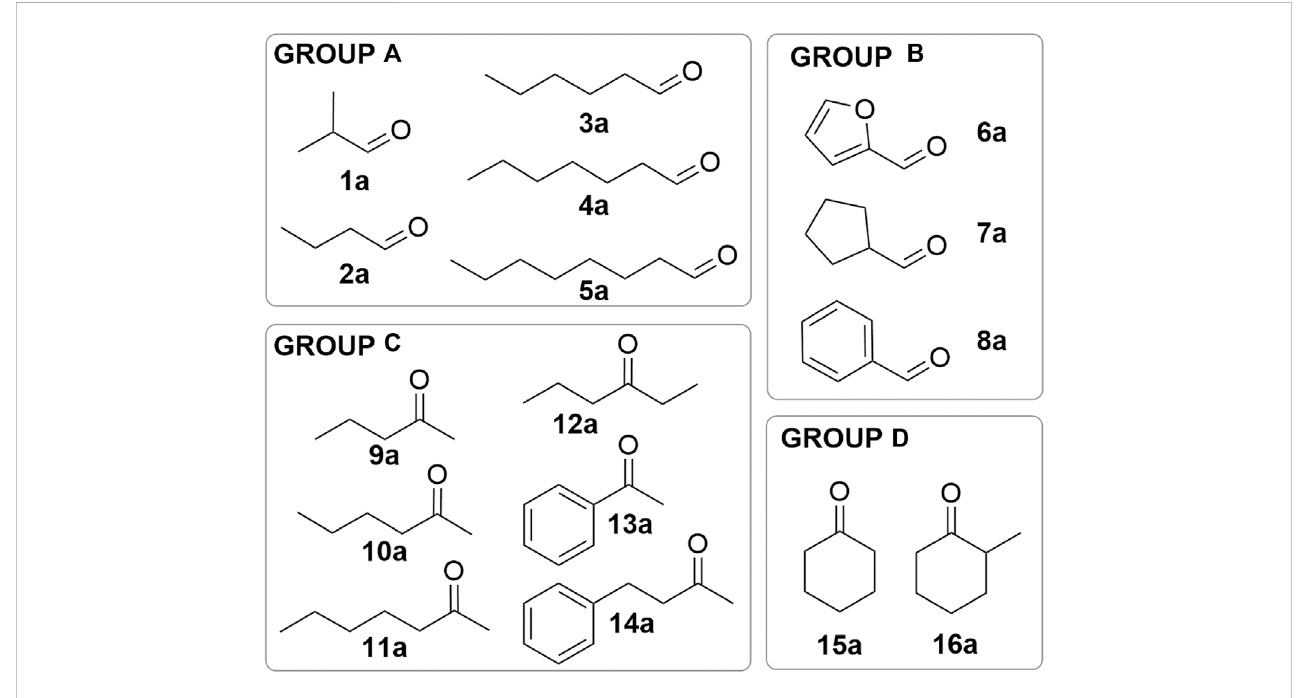
FIGURE 1 List of substrates used in this